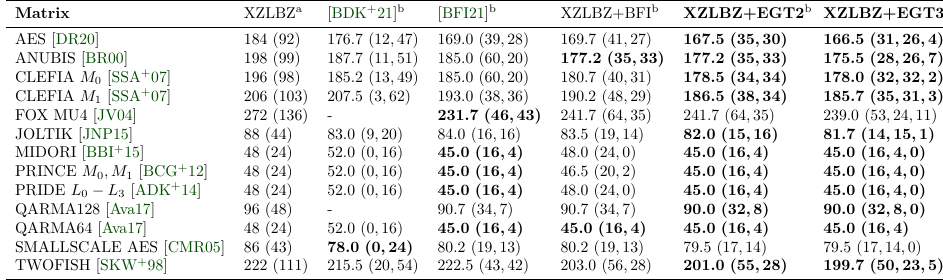
Table 2: The results of implementation cost of matrices in the library named STM 90 nm. The results consist of the circuit area (GE) and the gates. We use “( m )” to represent m 2-input xor gates, use “( m, p )” to represent m 2-input xor gates and p 3-input xor gates, and use “( m, p, q )” to represent m 2-input xor gates and p 3-input xor gates and q 4-input xor gates.